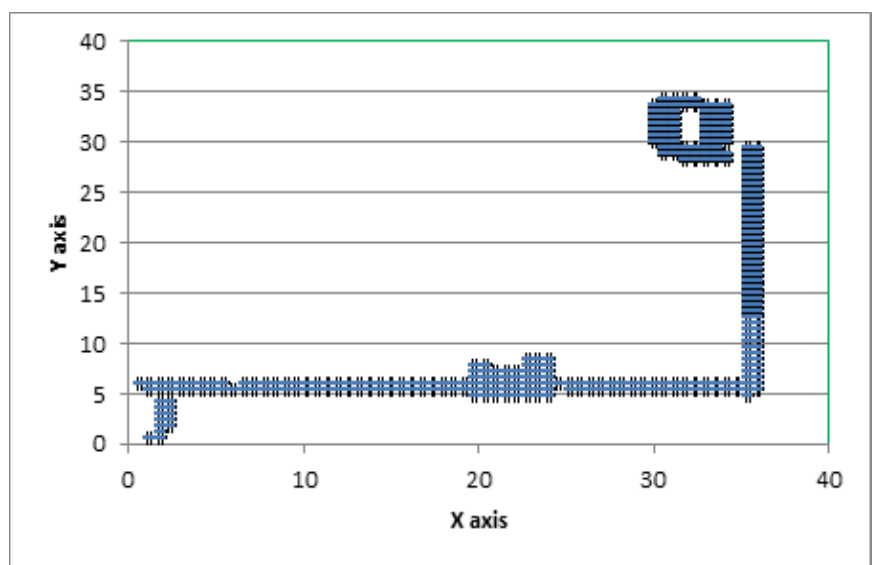
Figure 13. Actual ( x , y ) position based on the dataset. Sensors 2020 , 20 , 6238